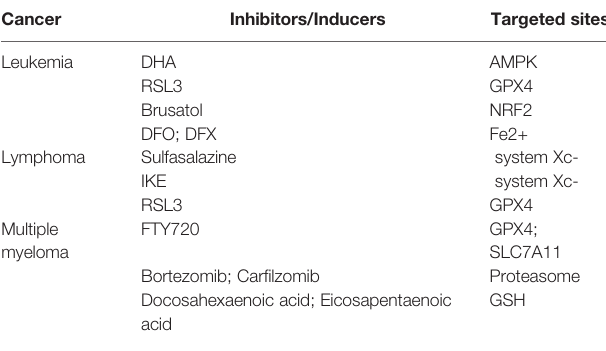
TABLE 1 | Inducers or inhibitors of ferroptosis in hematologic malignancies.